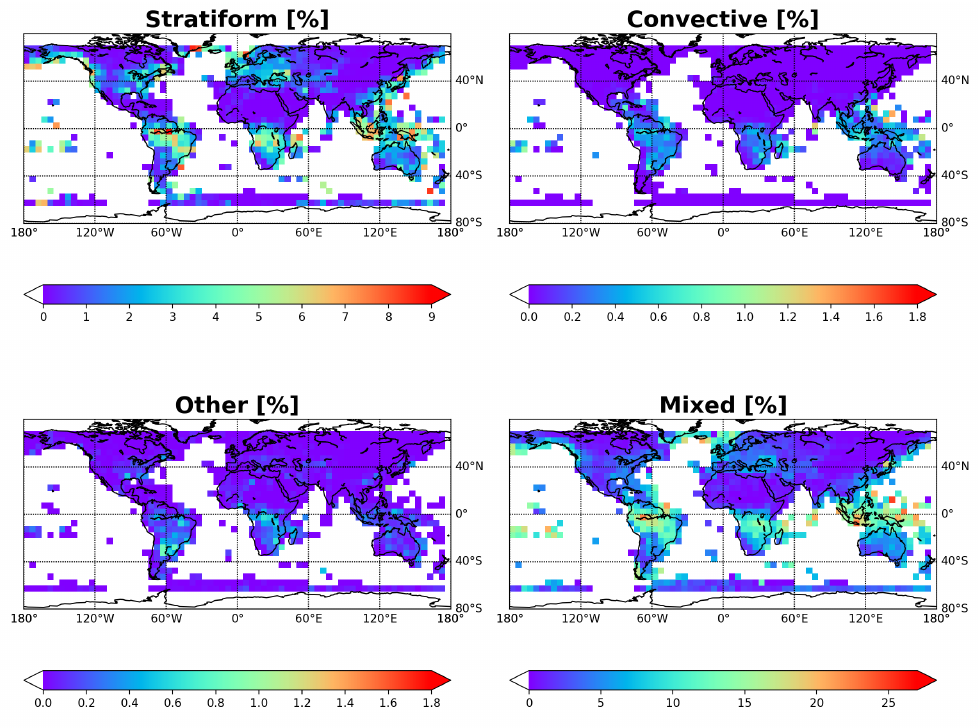
Figure 11. Same as Figure 10, except from the DPR “truth” during DJF, 2016 and